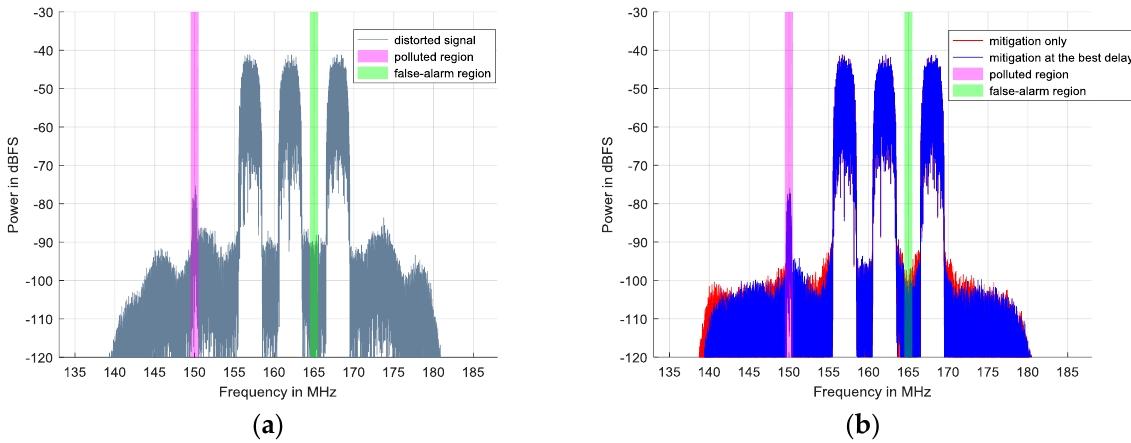
Figure 9. Nonlinearity mitigation results of simulation signals including three strong 16QAM signals and one weak 16QAM signal: ( a ) distorted signals; and ( b ) signals after nonlinearity mitigation.